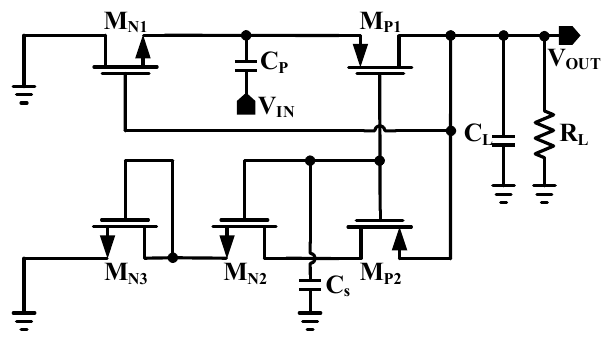
Figure 3. Circuit diagram of proposed RF-DC converter.